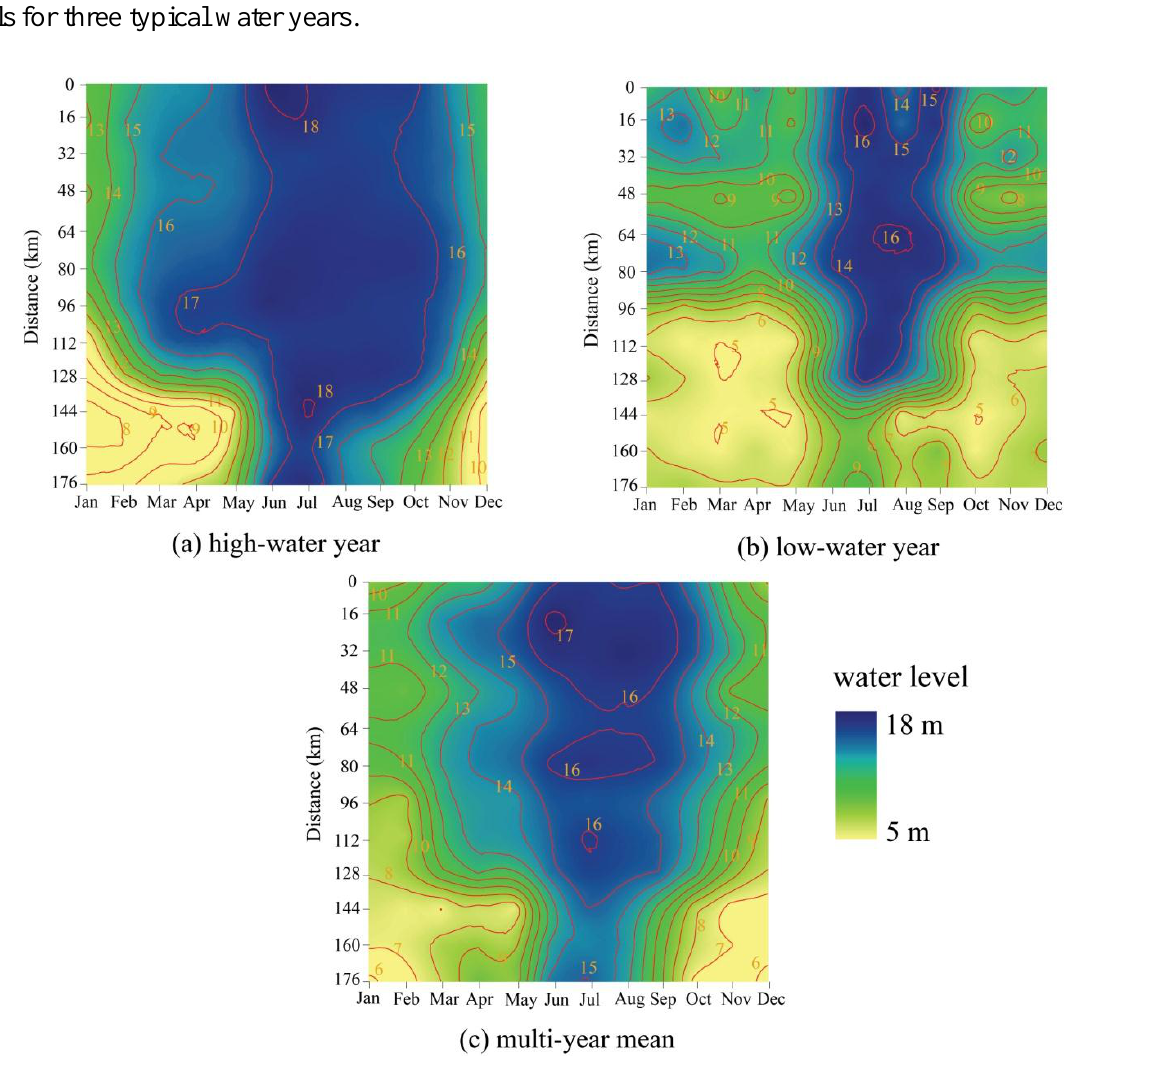
Figure 8. Spatially-averaged water level variation patterns along the north-south profile during different typical years (( a ) high-water year (2012); ( b ) low-water year (2011); ( c ) multi-year mean). Contour lines show the water height above sea level. The value of the ordinate axis is the profile distance from north to